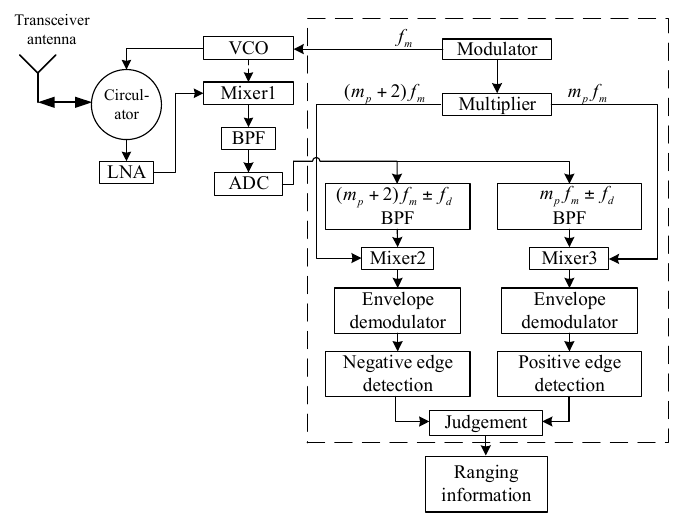
Figure 3. Block diagram of multi-harmonic timing sequence detection based on BPF.